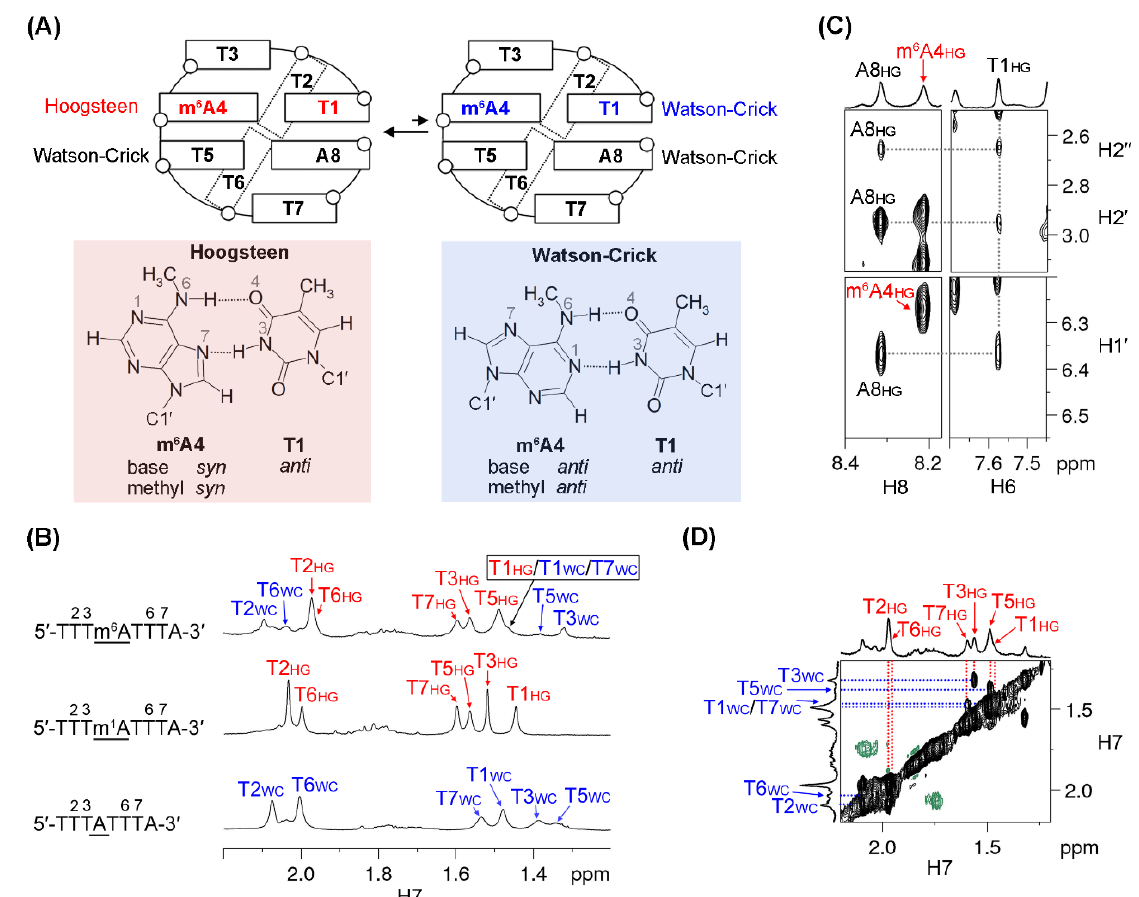
Figure 4. ( A ) 5′-TTTm 6 ATTTA-3′ displayed a conformational exchange between two MDBs with T1·m 6 A4 Hoogsteen and Watson–Crick base pairs, respectively. ( B ) Comparison of the H7 signals of 5′-TTTm 6 ATTTA-3′ (top) with those in the m 1 A MDB (middle) and the TTTA MDB (bottom). The 1D 1 H spectra were acquired at 0 °C. The subscripts “WC” and “HG” mean that T1·m 6 A4/ T1·m 1 A4/T1-A4 formed a Watson–Crick and Hoogsteen base pair respectively, in the corresponding structure. ( C ) NOEs of A8 H1′/H2′/H2′′-T1 H6 supported the formation of an MDB for the major conformer. The NOESY spectrum was acquired at 15 °C with a mixing time of 600 ms. ( D ) The H7 signals of the minor conformer were assigned based on their exchange cross peaks with the corresponding signals of the major conformer in a rotating frame Overhauser effect spectroscopy (ROESY) spectrum. The ROESY spectrum was acquired at 0 °C with a spinlock time of 200 ms.